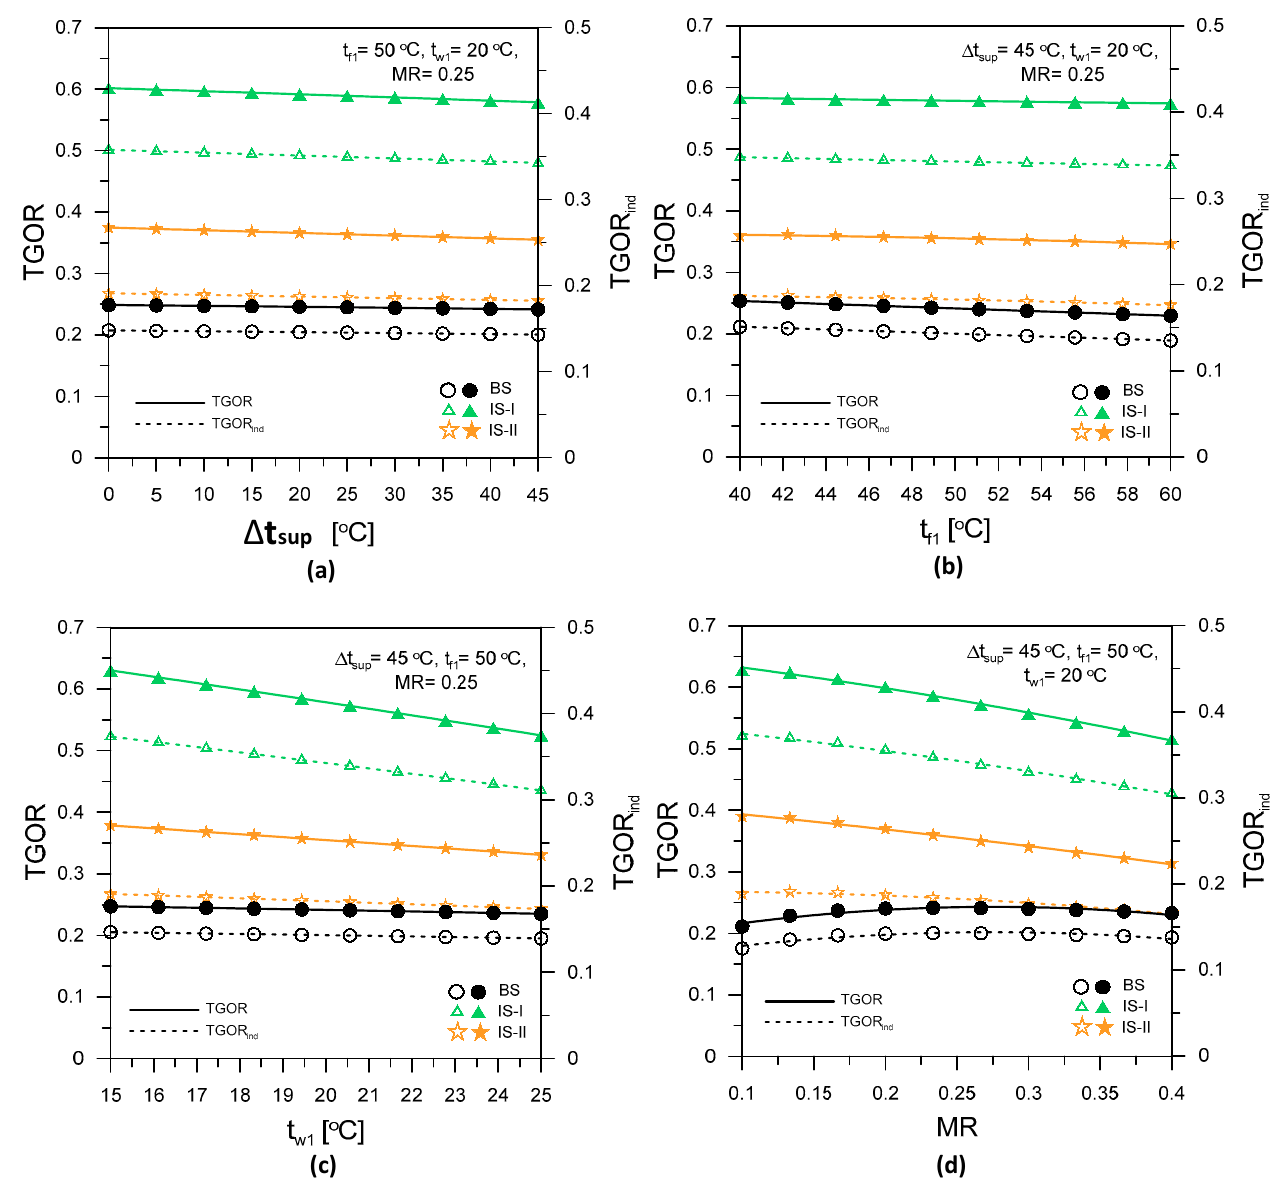
Figure 2. Comparisons of proposed systems with independent individual systems on TGOR & TGOR ind for different operating parameters: ( a ) ∆ t sup ; ( b ) t f1 ; ( c ) t w1 ; ( d ) MR.